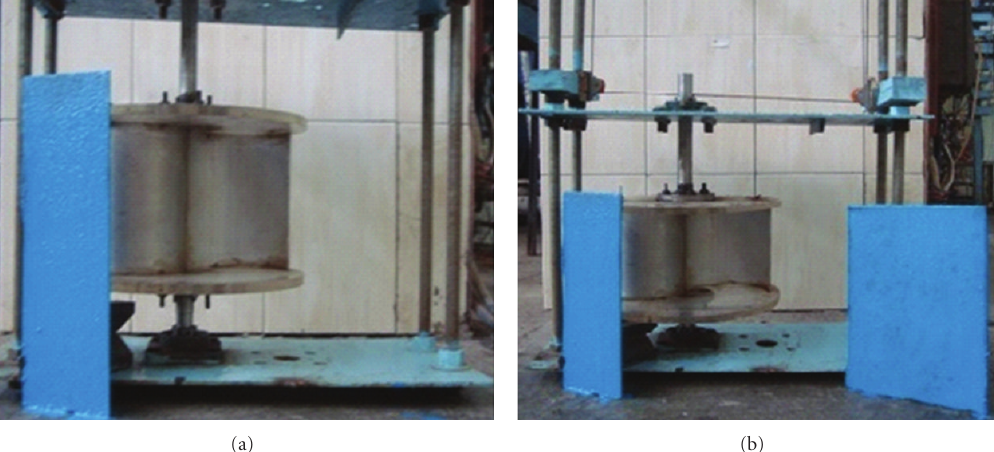
Figure 14: Pictorial representation of the modified Savonius rotor with deflector plate on the returning blade side (a) and rotor with two deflector plates